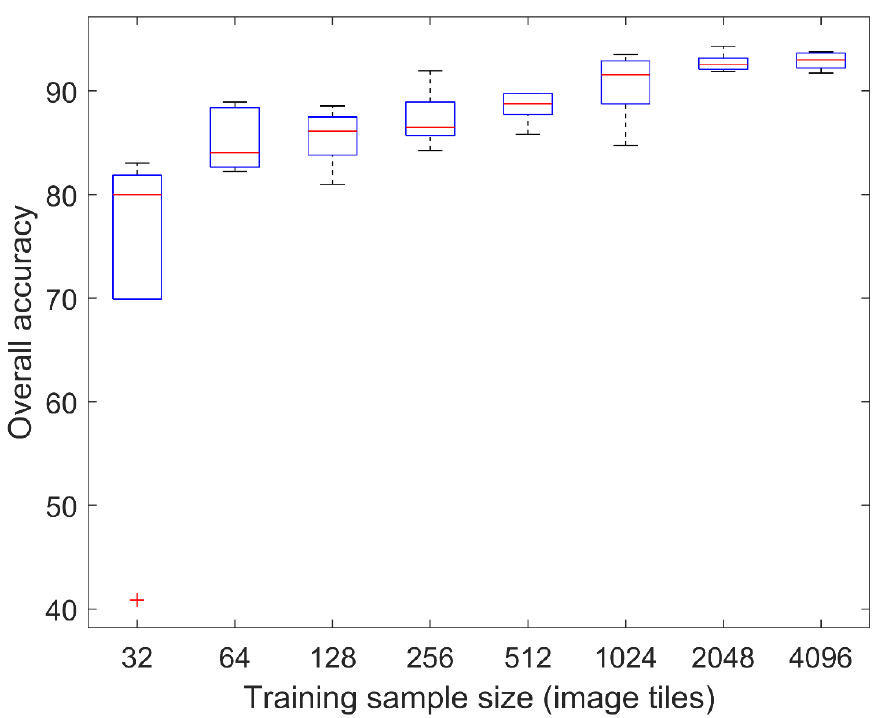
Figure 5. Cross-validation accuracies across varying sample sizes. Image tiles (32 to 4096) were